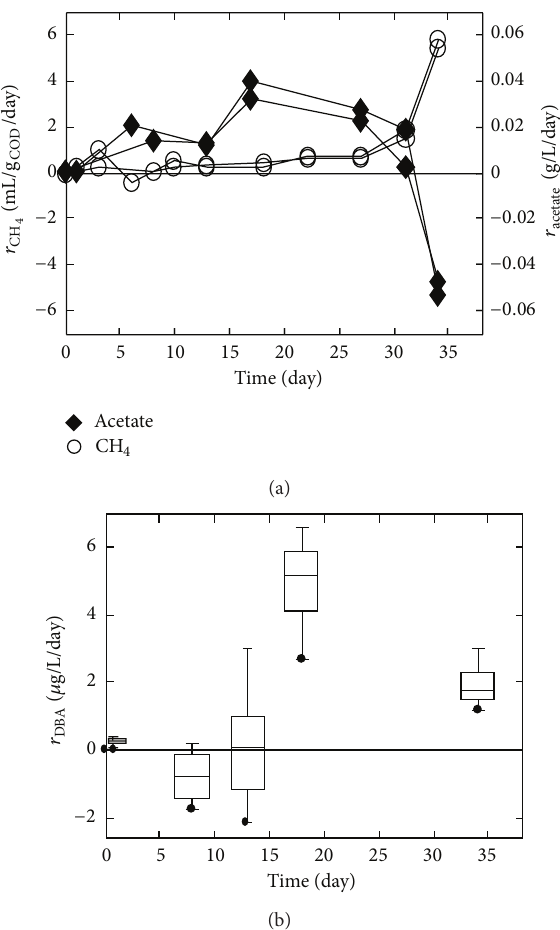
Figure 3: Removal kinetic of DBA coupled to methane production kinetic and acetate accumulation kinetic during the anaerobic digestion of HLSS (series B). The initial 𝜇 P concentrations were measured in duplicate. Two reactors were stopped at different sampling